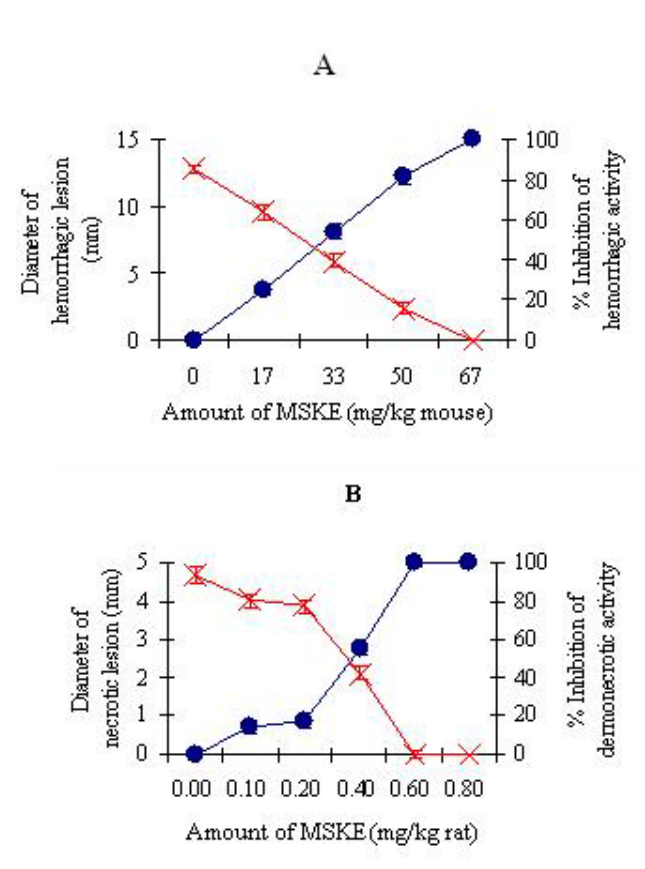
Figure 4. Inhibition of hemorrhagic activity of CR venom (61.2 µg/mouse) in mice (n = 8) (A) and inhibition of dermonecrotic activity of NK venom (63 µg/rat) in rats (n = 4) (B) by MSKE. Diameters of hemorrhagic and necrotic lesions (×). Percentage inhibition of hemorrhagic and necrotic activities ( ●